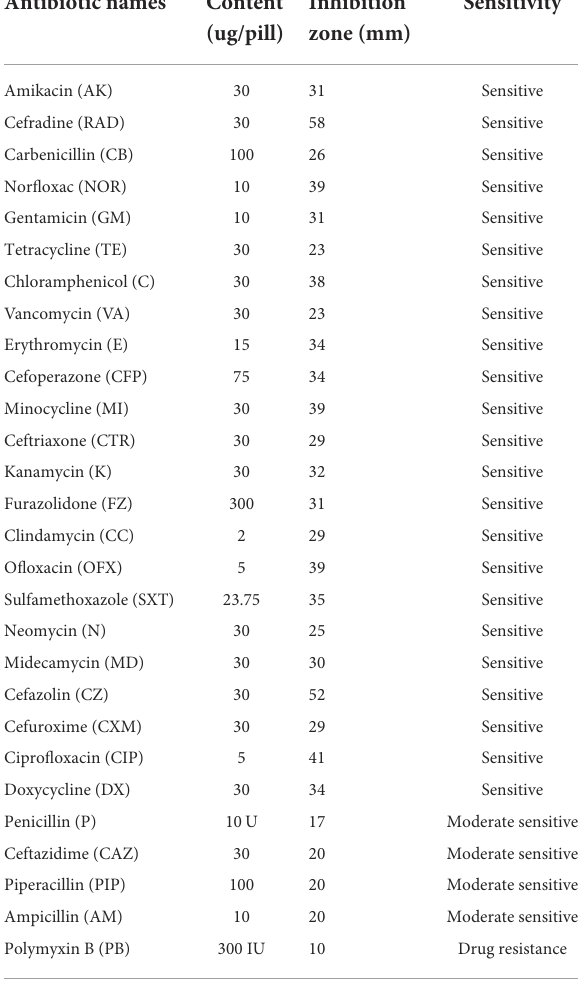
TABLE 2 Antibiotic sensitivity of B. subtilis M6